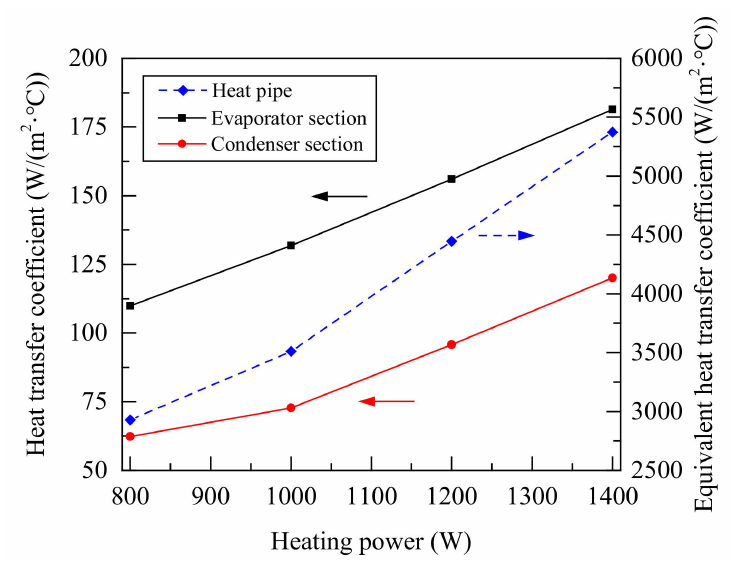
Figure 10. Heat transfer coefficient of heat pipe under different heating